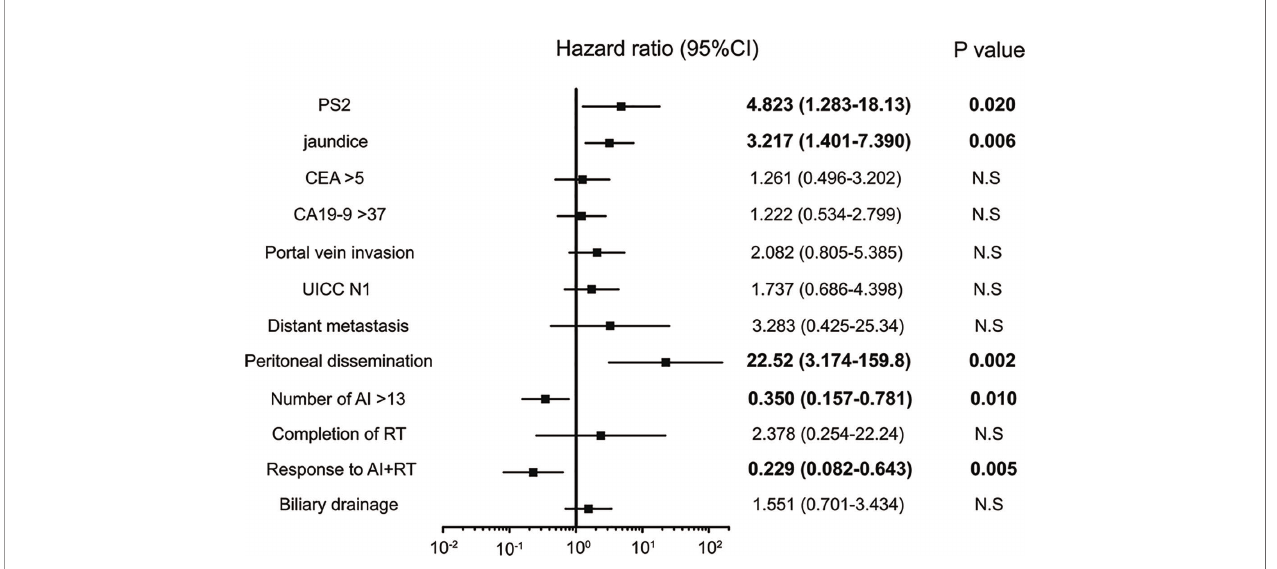
FIGURE 3 | Signi fi cant independent prognostic factors of biliary tract cancer (BTC). PS2, jaundice, peritoneal dissemination, number of AI sessions, response to AI+RT and biliary drainage were signi fi cant independent prognostic factors of BTC. Peritoneal dissemination had the highest hazard ratio (HR) at 22.5, while a response to AI+RT showed the lowest HR at 0.23.